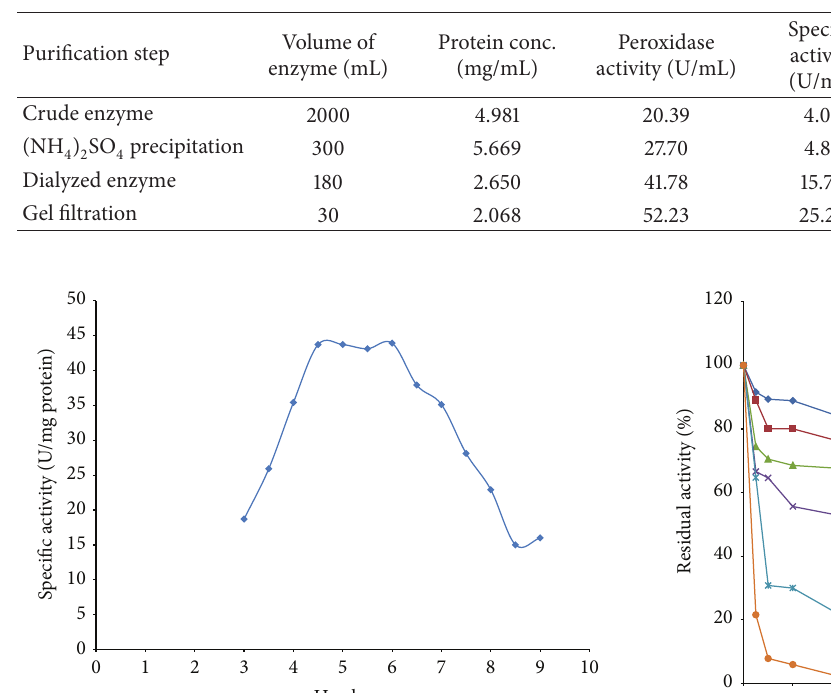
Table 1: Purification table of garlic peroxidase.